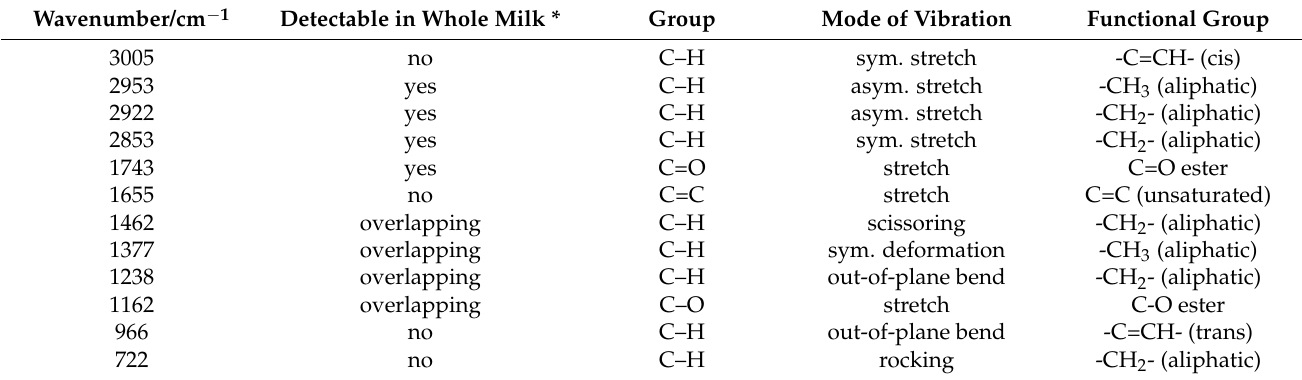
Table 1. Characteristic mid-IR absorption bands of milk fat